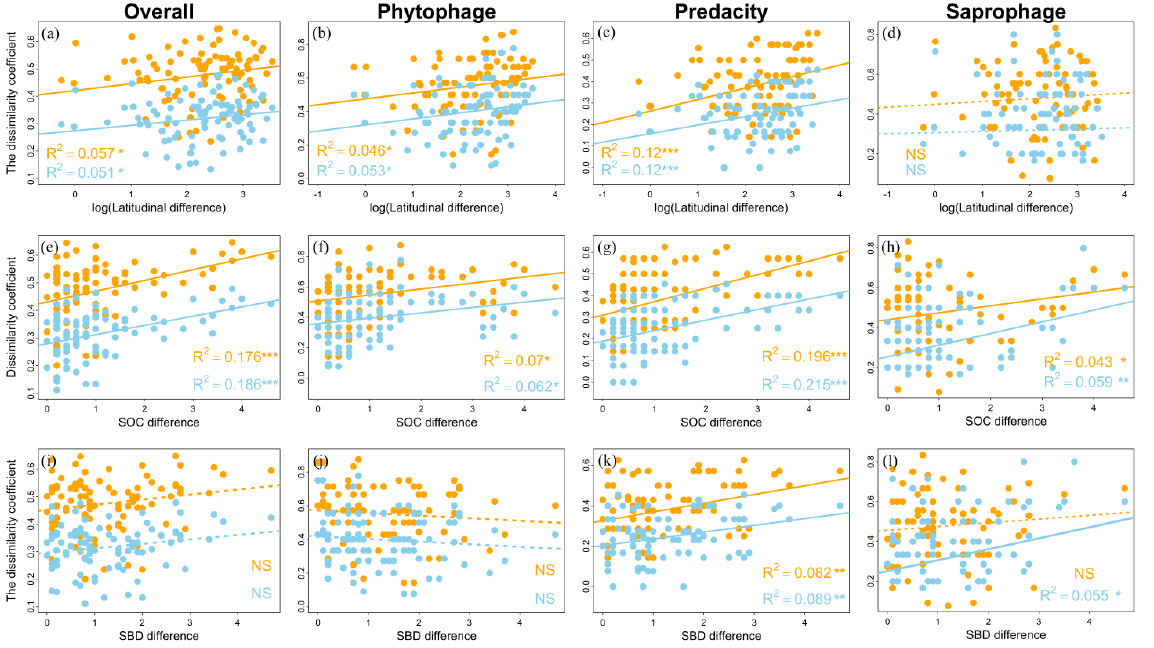
Figure 5. Patterns of overall ( a , e , i ); phytophagous ( b , f , j ); predatory ( c , g , k ) and saprophagous ( d , h , l ), fauna in different sampling sites along the latitude and soil factor differences in East Asia. Orange dots and lines represent βj and blue dots and lines represent βs ; n = 91; “*”, “**” and “***” represent p ≤ 0.05, 0.01 and 0.001, respectively. “NS” indicates p > 0.05. (Note: SOC = soil organic carbon and SBD = soil bulk density).